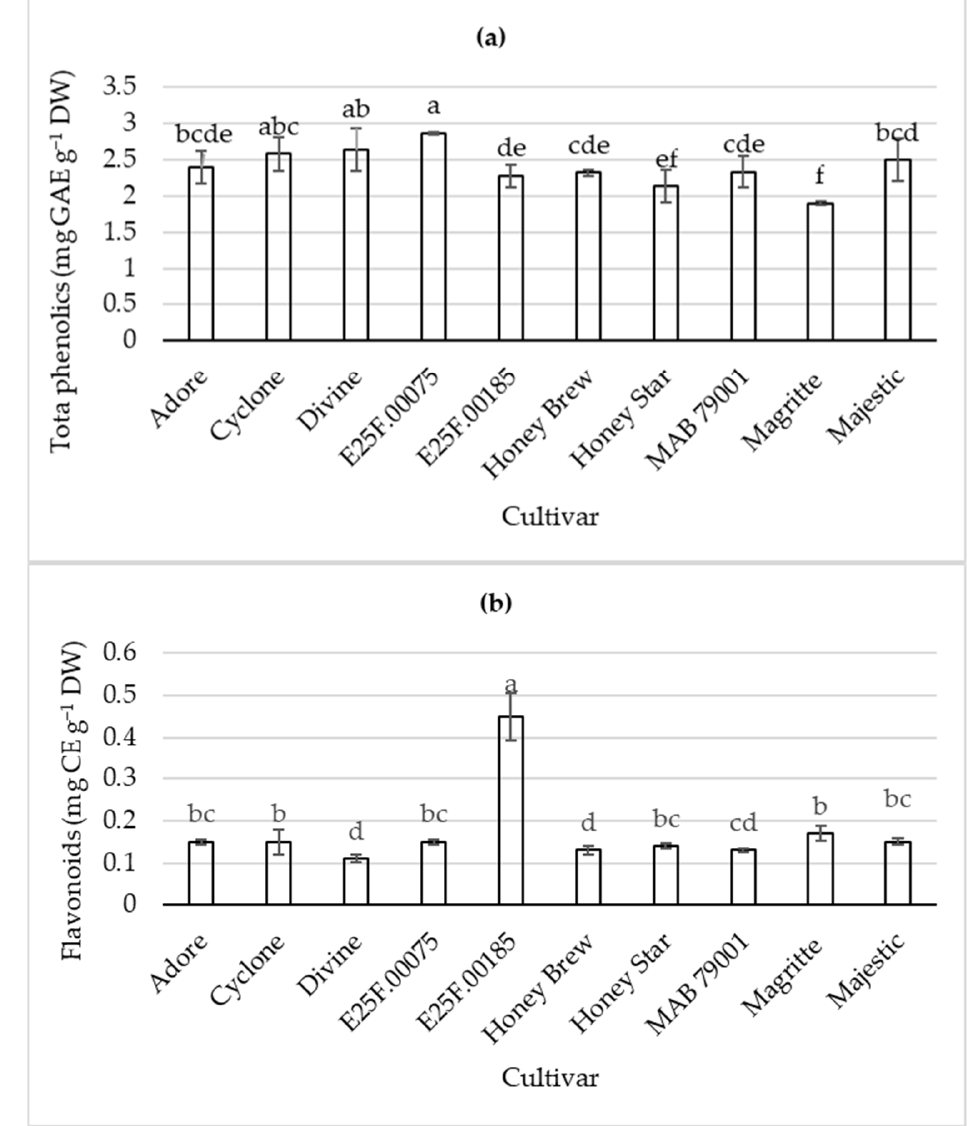
Figure 2. Total phenolics ( a ) and flavonoid ( b ) contents of fruit from sweet melon cultivars at harvest. Bars (with error bars indicating standard error of means) with different letters are significantly different at p ≤ 0.05 (Fisher’s protected LSD test, n = 4). GAE = gallic acid equivalent; CE = catechin equivalent; DW = dry weight.